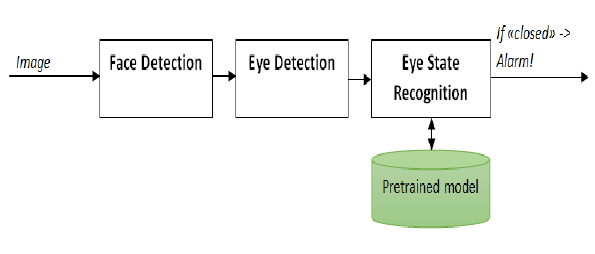
Figure 5 . Scheme of the eye condition analysis